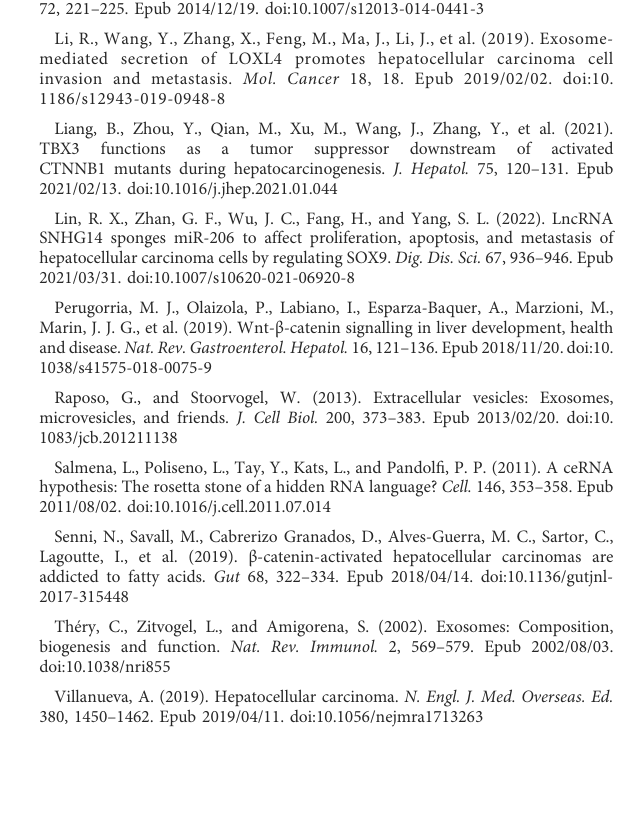
SUPPLEMENTARY FIGURE S1 Correlation analyses between risk score and different clinical subgroups (A) correlation analyses between risk score and different age subgroups. (B) correlation analyses between risk score and different gender subgroups. (C) correlation analyses between risk score and different grade subgroups. (D) correlation analyses between risk score and different stage